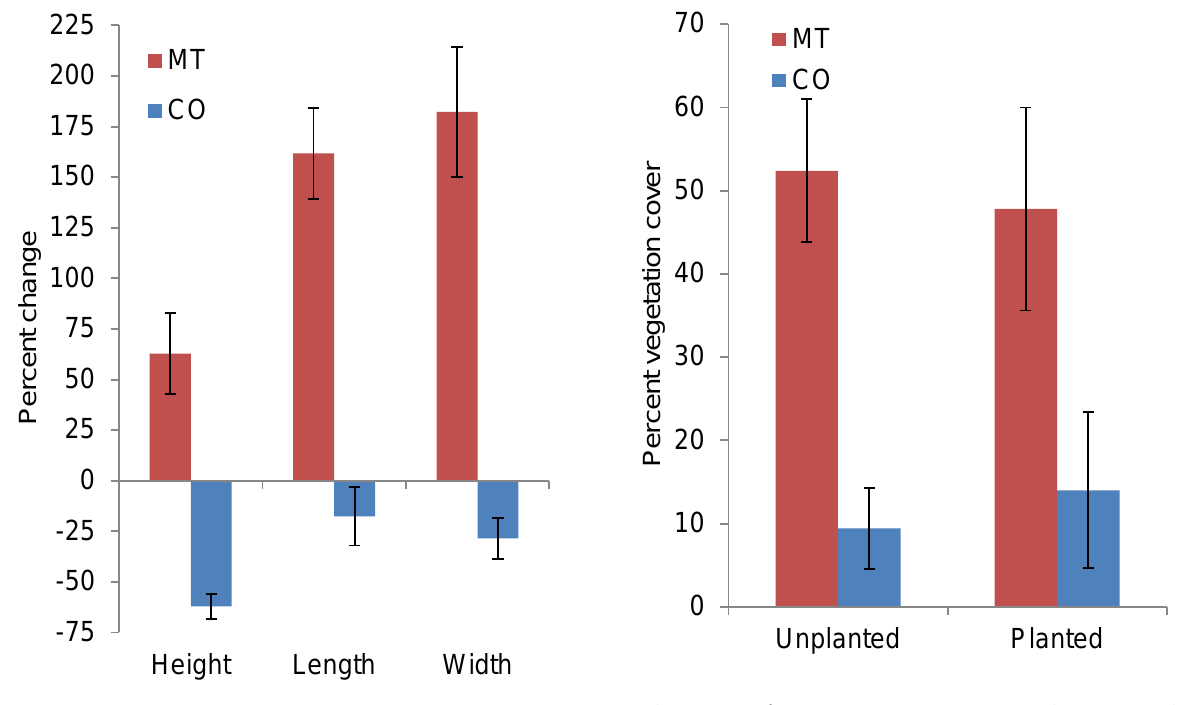
Figure 6. The mean percentage change in height, length and width of surviving Calluna vulgaris cuttings three years after planting. n = 24 for Meall nan Tarmachan (MT) and n = 8 for Coire Odhar (CO). Error bars are ± 1 SE.